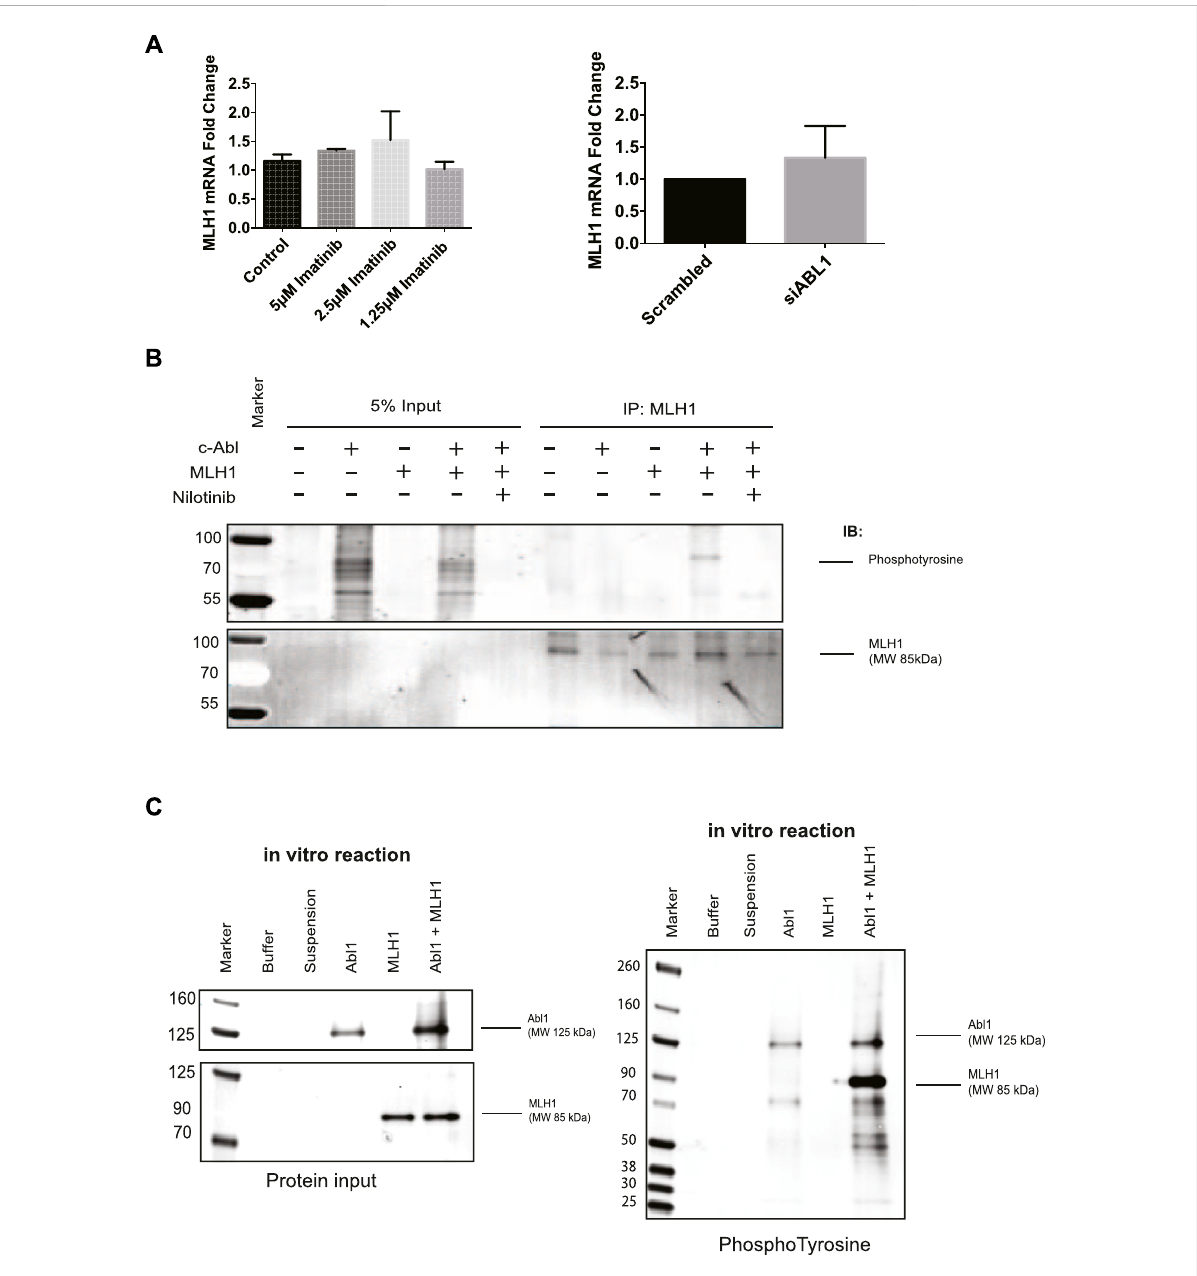
ABL1 phosphorylates MLH1. (A) MLH1 mRNA fold change with ABL1 knockdown (left) or inhibition by imatinib (right) determined by RT-qPCR n = 3 (B) MLH1 immunoprecipitation in HEK293 cells with ABL1 and MLH1 overexpressed followed by immunoblot with anti-phosphotyrosine antibody.Treatmentwith5 μ Mnilotinibreducesthephospho-tyrosinesignalassociatedwithMLH1. (C) KinaseassayusingrecombinantABL1(25 ng) and MLH1 (100 ng) protein incubated for 15 min, followed by SDS-PAGE and immunoblot analysis indicates tyrosine phosphorylation of MLH1 only in the presence of ABL1